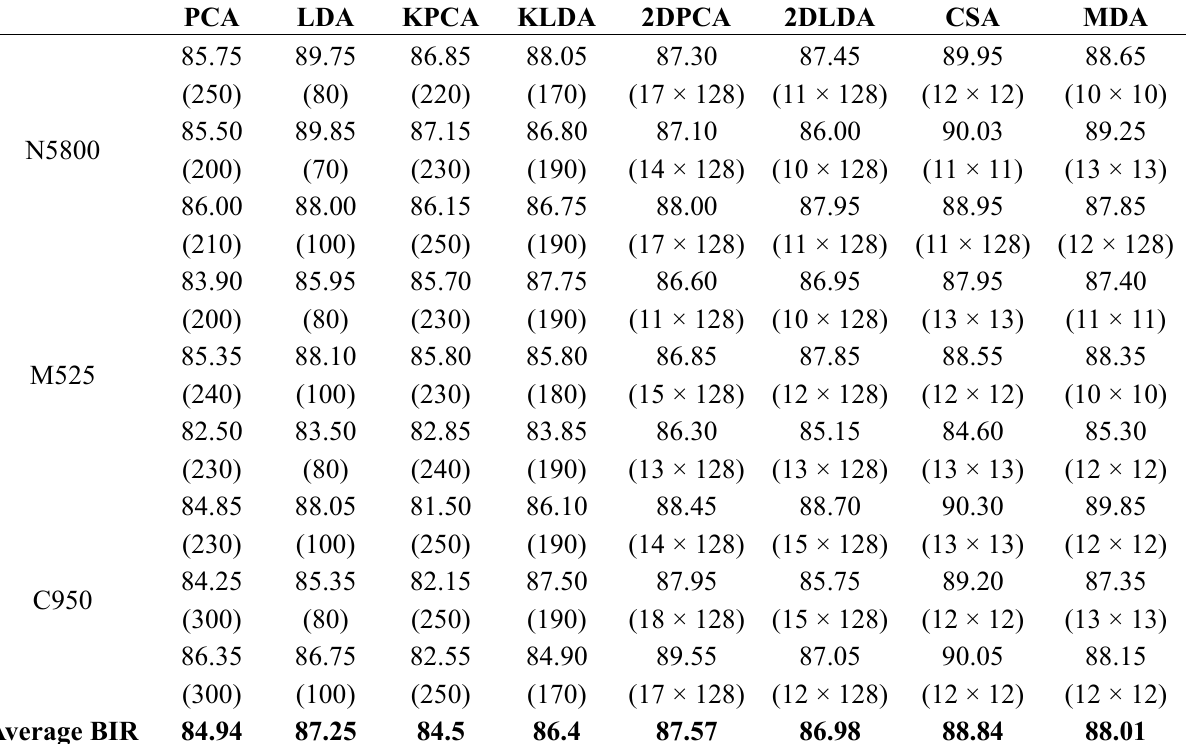
Table 1. BIRs (%) and corresponding dimensions (the number in the bracket) of different subspace learning methods conducted three times on three